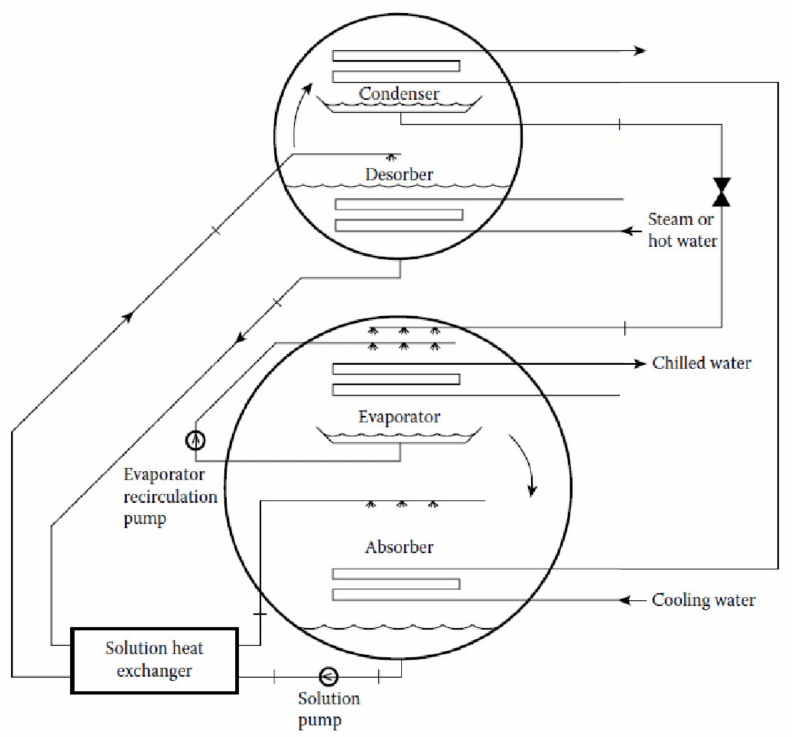
Figure 1. Schematic diagram of a single-effect water/lithium bromide absorption chiller. Adapted from [45].